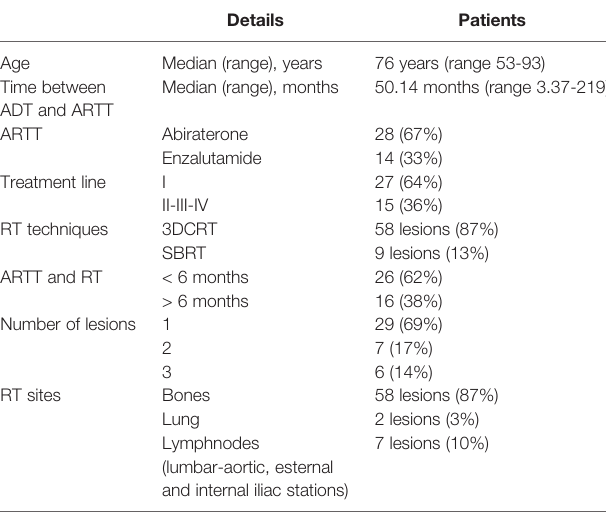
TABLE 1 | Patients characteristics (n = 42).